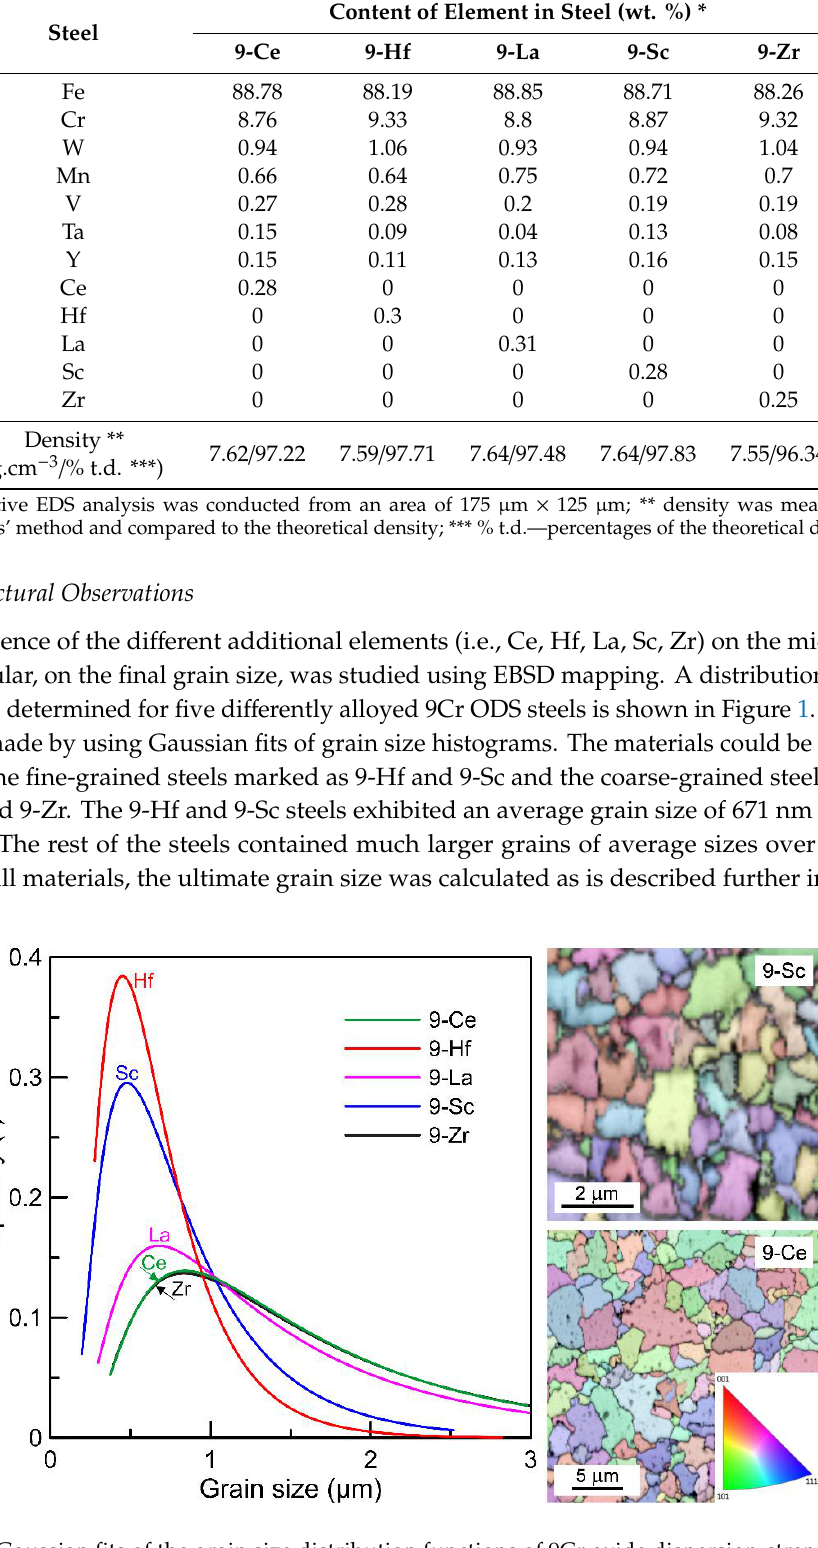
Figure 1. Gaussian fits of the grain size distribution functions of 9Cr oxide dispersion-strengthened (ODS) steels with different types of oxide dispersions. The EBSD maps show the overall microstructure of fine-grained (9-Sc) and coarse-grained (9-Ce) steels.